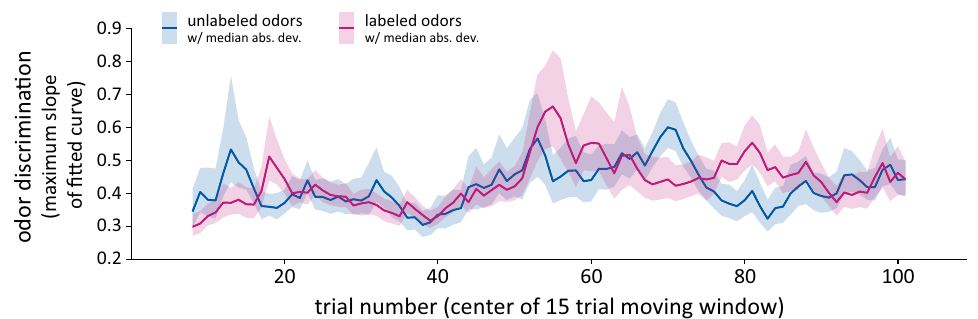
Figure 3. Time-resolved odor discrimination over the course of the experiment. We computed group-level odor discrimination within a fifteen-trial moving window using the PSE-aligned data from each condition. We used a bootstrap resampling procedure to generate confidence intervals around the estimated odor discrimination performance. Solid lines indicate the median of the bootstrapped distribution and the shaded regions show ± 1 median absolute deviation around the median, computed separately in the positive and negative directions. We found a small but significant overall improvement in odor discrimination over time ( p = 0.019; 1-tailed bootstrap test), but no difference in the rate of improvement between the Unlabeled Odors and Labeled Odors conditions ( p = 0.284; 2-tailed bootstrap